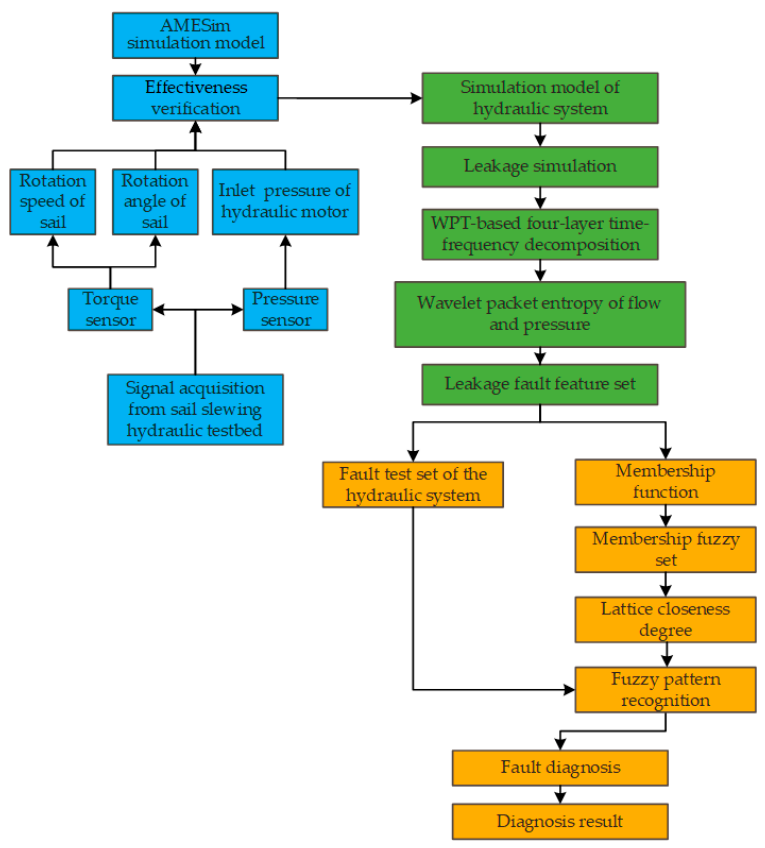
Figure 1. Process of the diagnosis